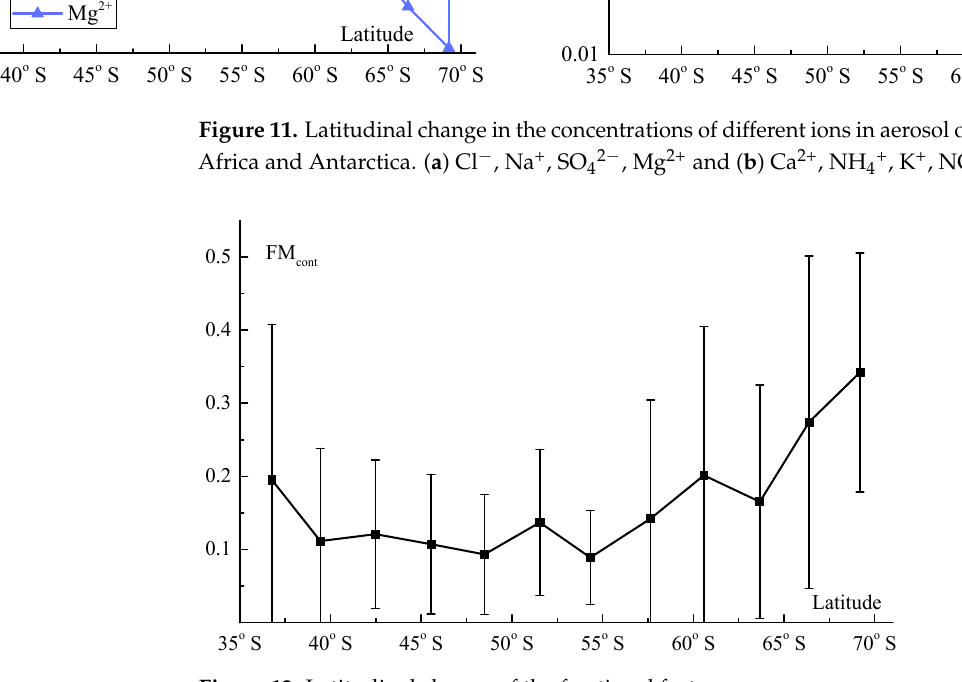
Figure 12. Latitudinal change of the fractional factor.